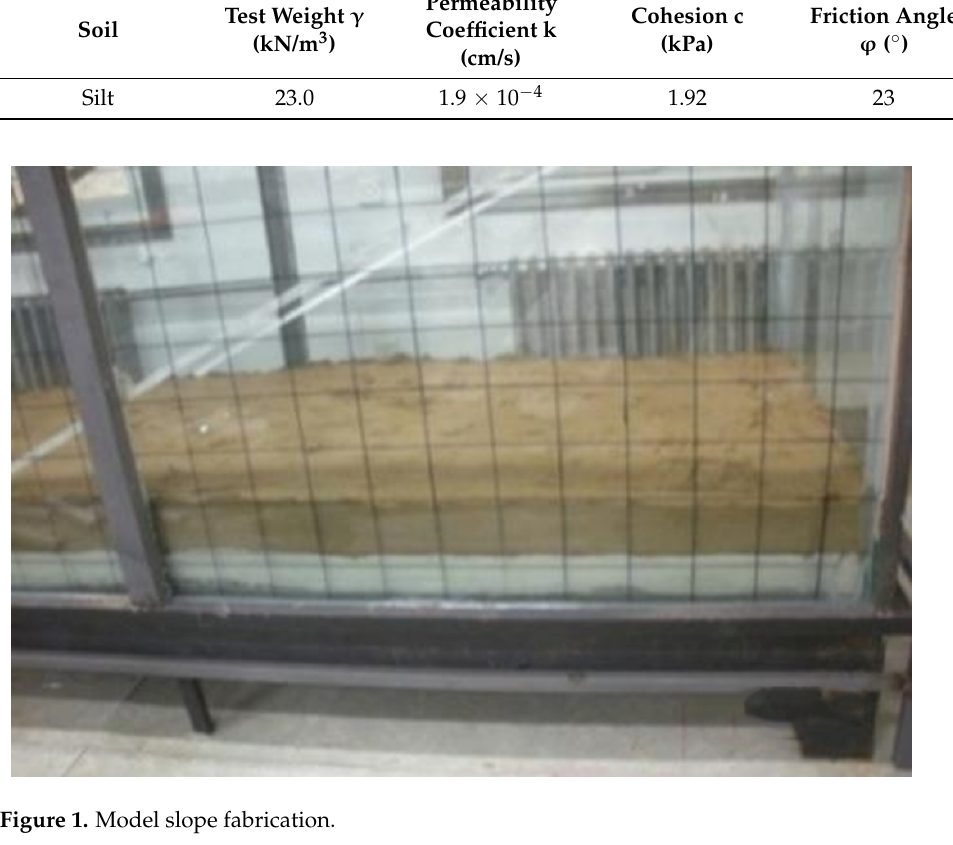
Table 1. Physical and mechanical parameters of soil mass.